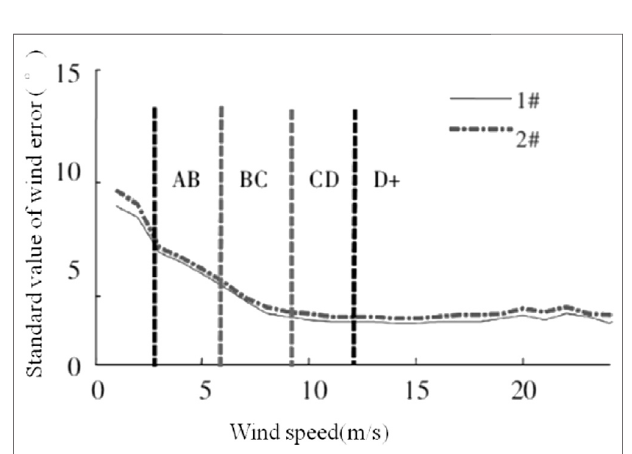
FIGURE 11 | The curve of wind error standard value changes with wind